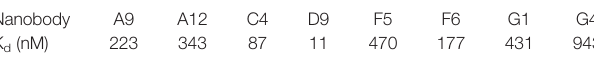
TABLE 1 | Apparent af fi nity of the nanobodies determined by ELISA.